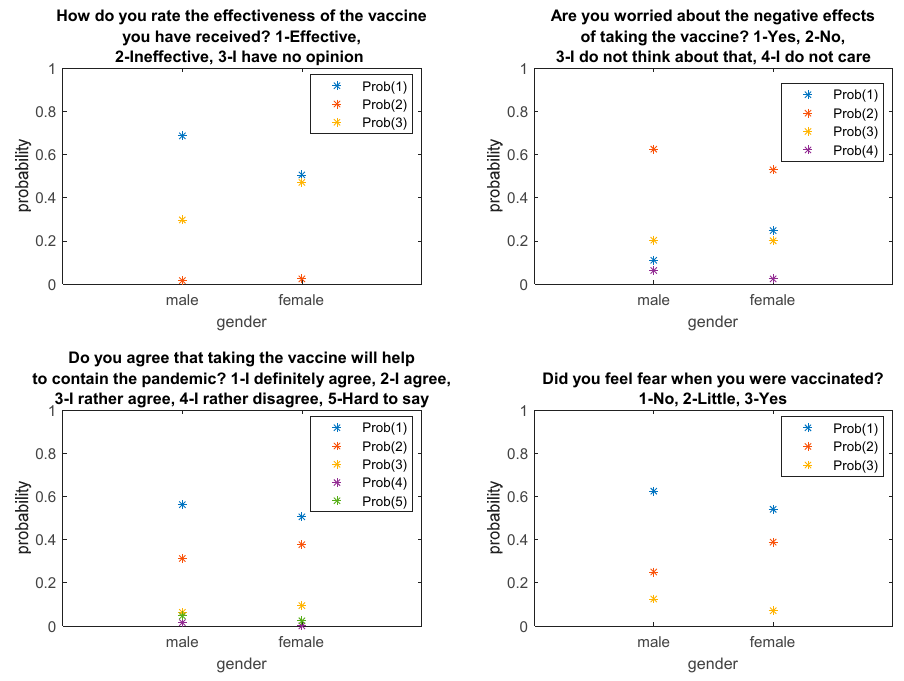
Figure 2. Probability distributions concerning respondents’ answers depending on gender. Table 4. Comparison of the number of side effects after taking the vaccine with age and gender. Side Effect after Taking the Vaccine